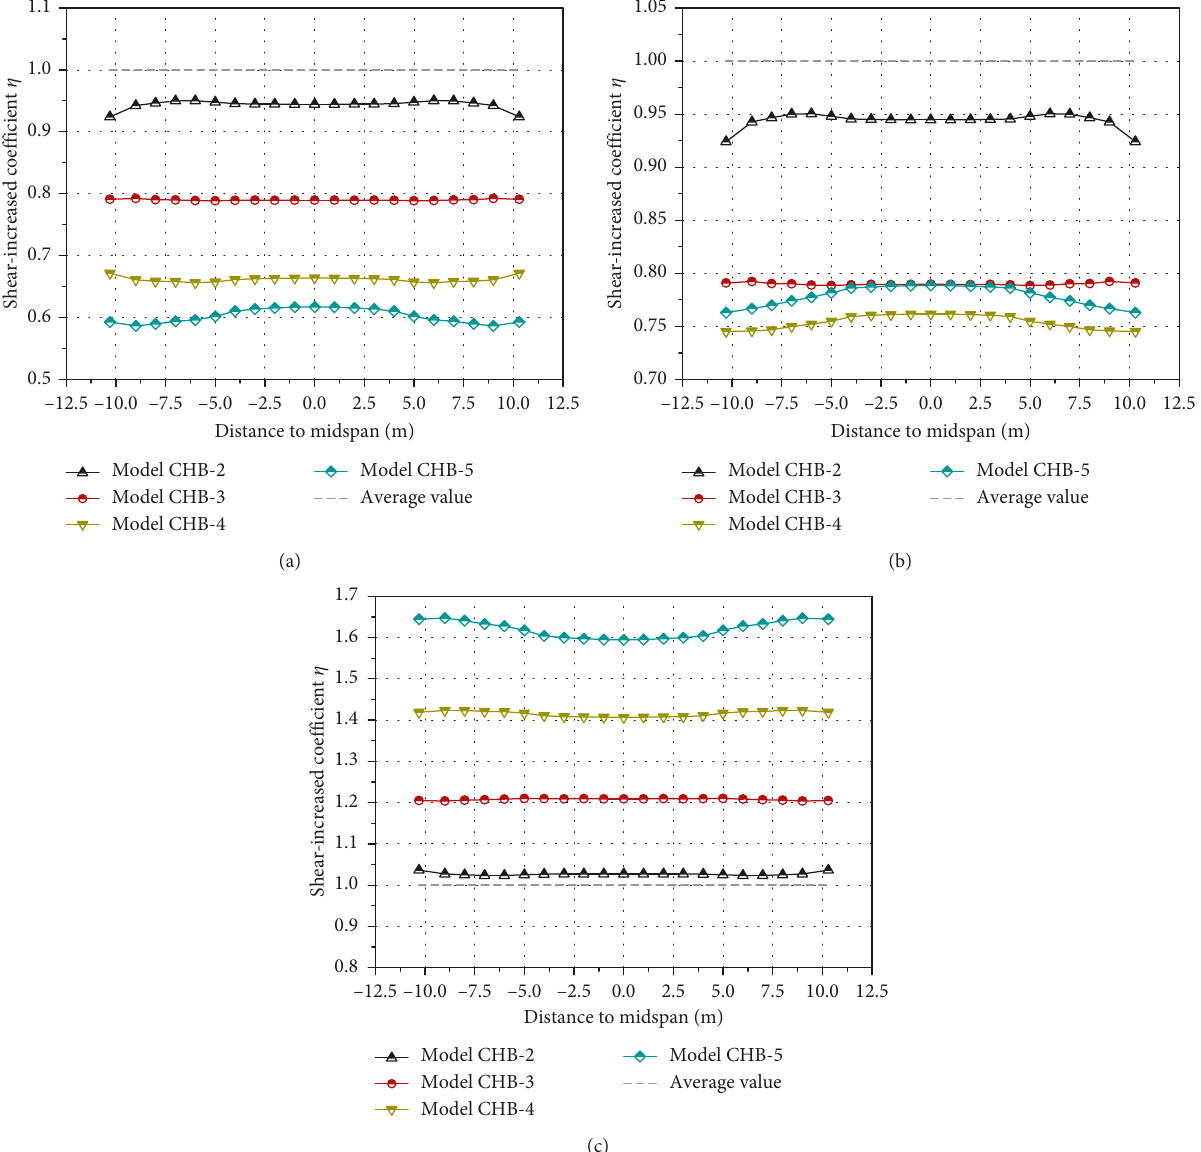
Figure 7: Shear-increased coefficient η with different numbers of chambers cases. (a) Shear-increased coefficient η of M-Webs. (b) Shear- increased coefficient η of SS-Webs. (c) Shear-increased coefficient η of